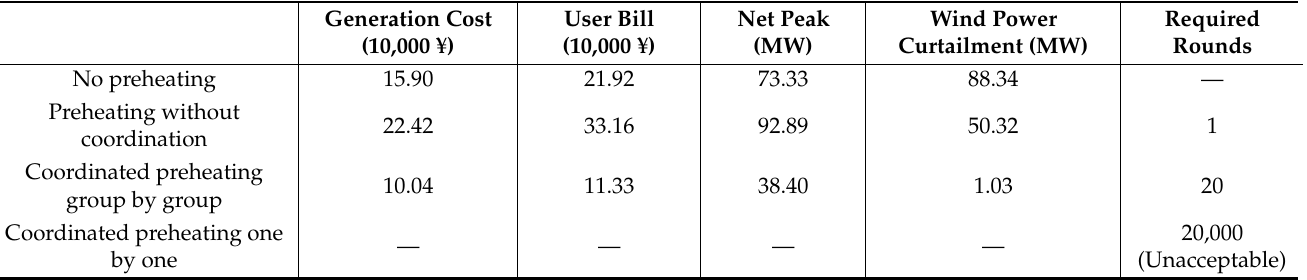
Table 4. Comparison of different preheating effects.